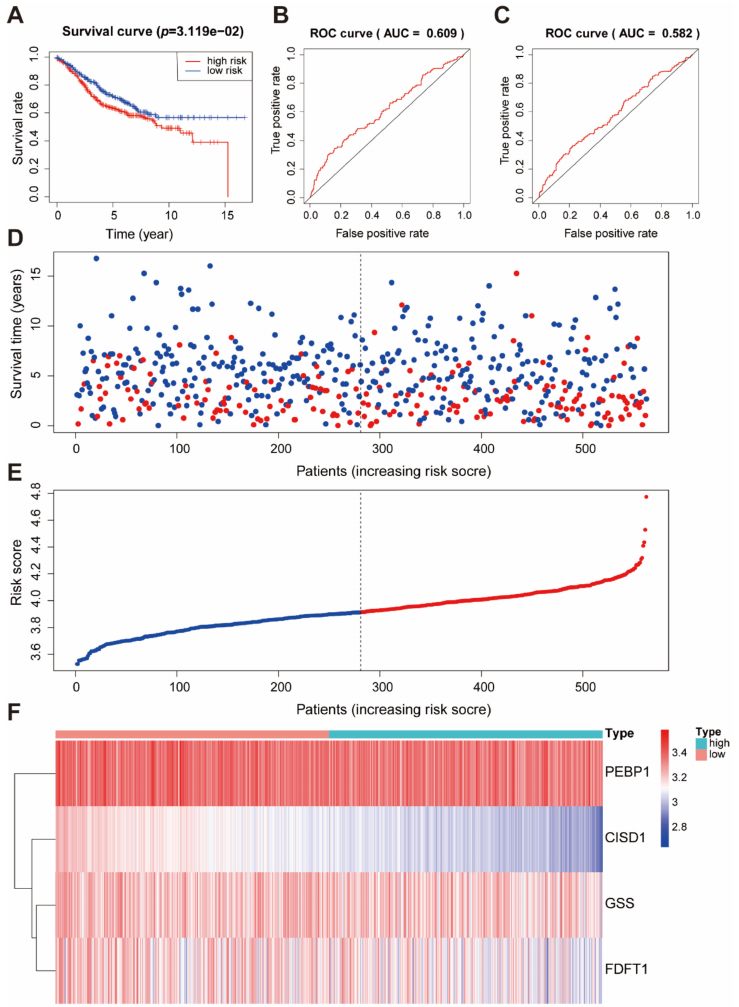
Figure 6. Verification of the prognostic performance of ferroptosis risk score in the GSE39582 cohort. ( A ) The survival curves of the ferroptosis risk score in the GSE39582 cohort. ( B , C ) ROC curve of the ferroptosis risk score forecast result after 3 and 5 years. ( D ) Patients’ survival status in the training set. The x-axis is the patient ranking in ascending order by the ferroptosis risk score; the y-axis is the survival time. The red dots represent patients who died, and the green dots represent the surviving patients. ( E ) The distribution and median value of the risk score in the GSE39582 cohort. ( F ) The PEBP1 , CISD1 , GSS , and FDFT1 expression in high or low risk score